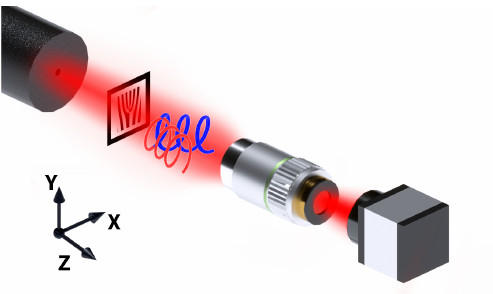
Figure 1. Illustration of the experiment. Ensembles of OVs of the opposite-sign form helical lines behind the FSG. Intensity distribution of the diffracted light is projected by the objective onto the CCD for